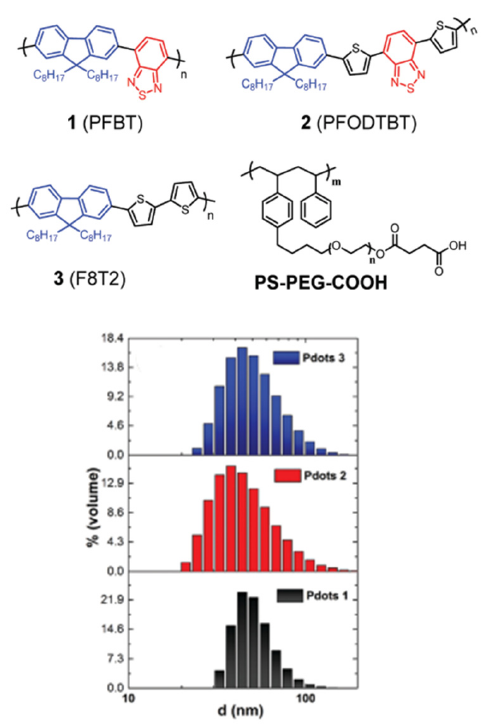
Figure 40. Donor-acceptor PDot structures with copolymer counterpart and dynamic light scattering (DLS) data indicating the relative size of the nanoparticles in each case. [Figure from ref. [159] under CC-BY 3.0 International License].